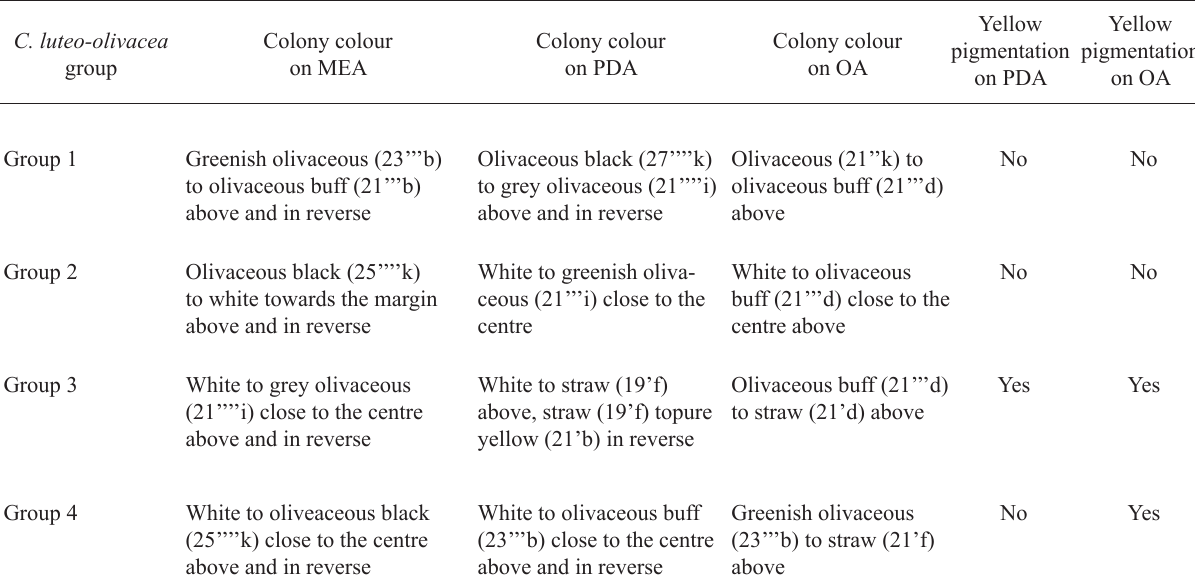
Colony colour on MEA